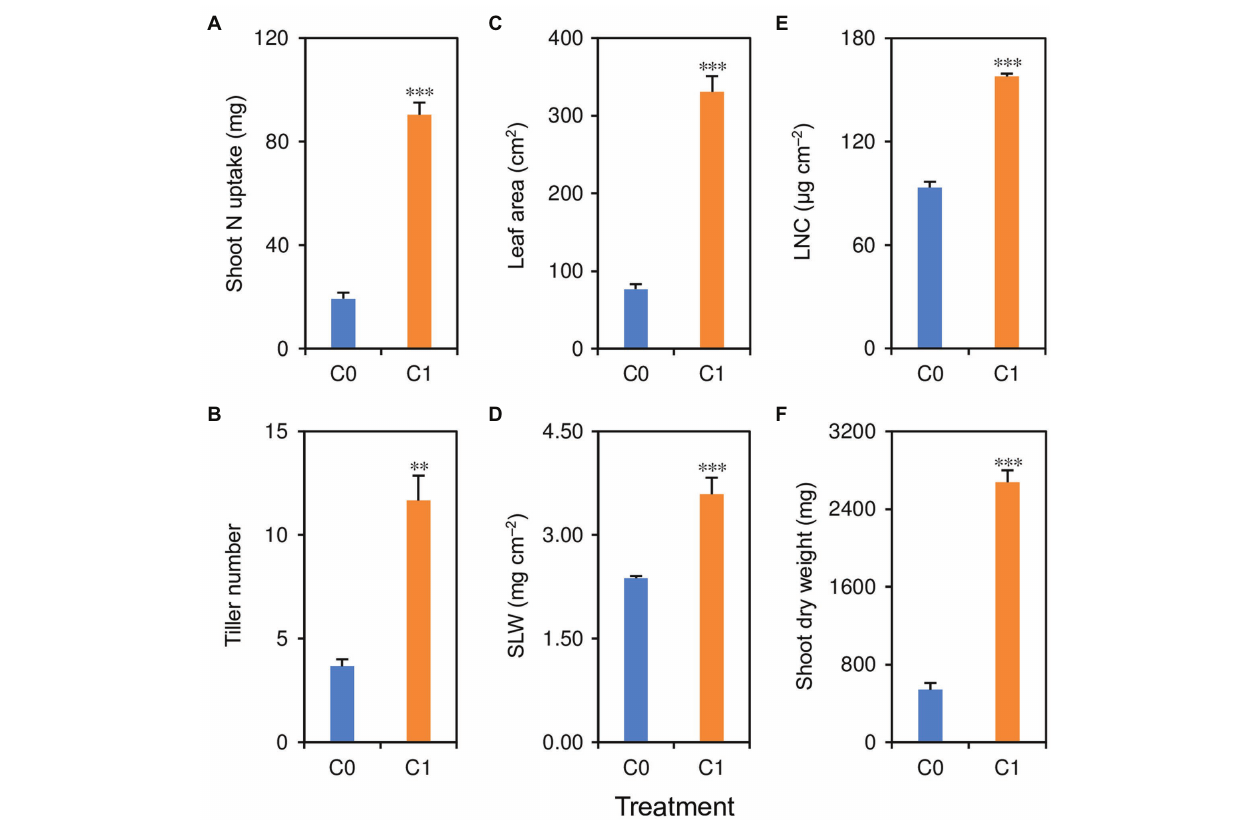
FIGURE 4 | (A) Shoot N uptake, (B) tiller number per plant, (C) leaf area per plant, (D) specific leaf weight, (E) leaf N content, and (F) shoot dry weight in rice plants grown with (C1) and without (C0) biochar application. ** and *** indicate that the means of the rice plants in C1 treatment are significantly different from those in the C0 treatment at the 0.01 and 0.001 levels,